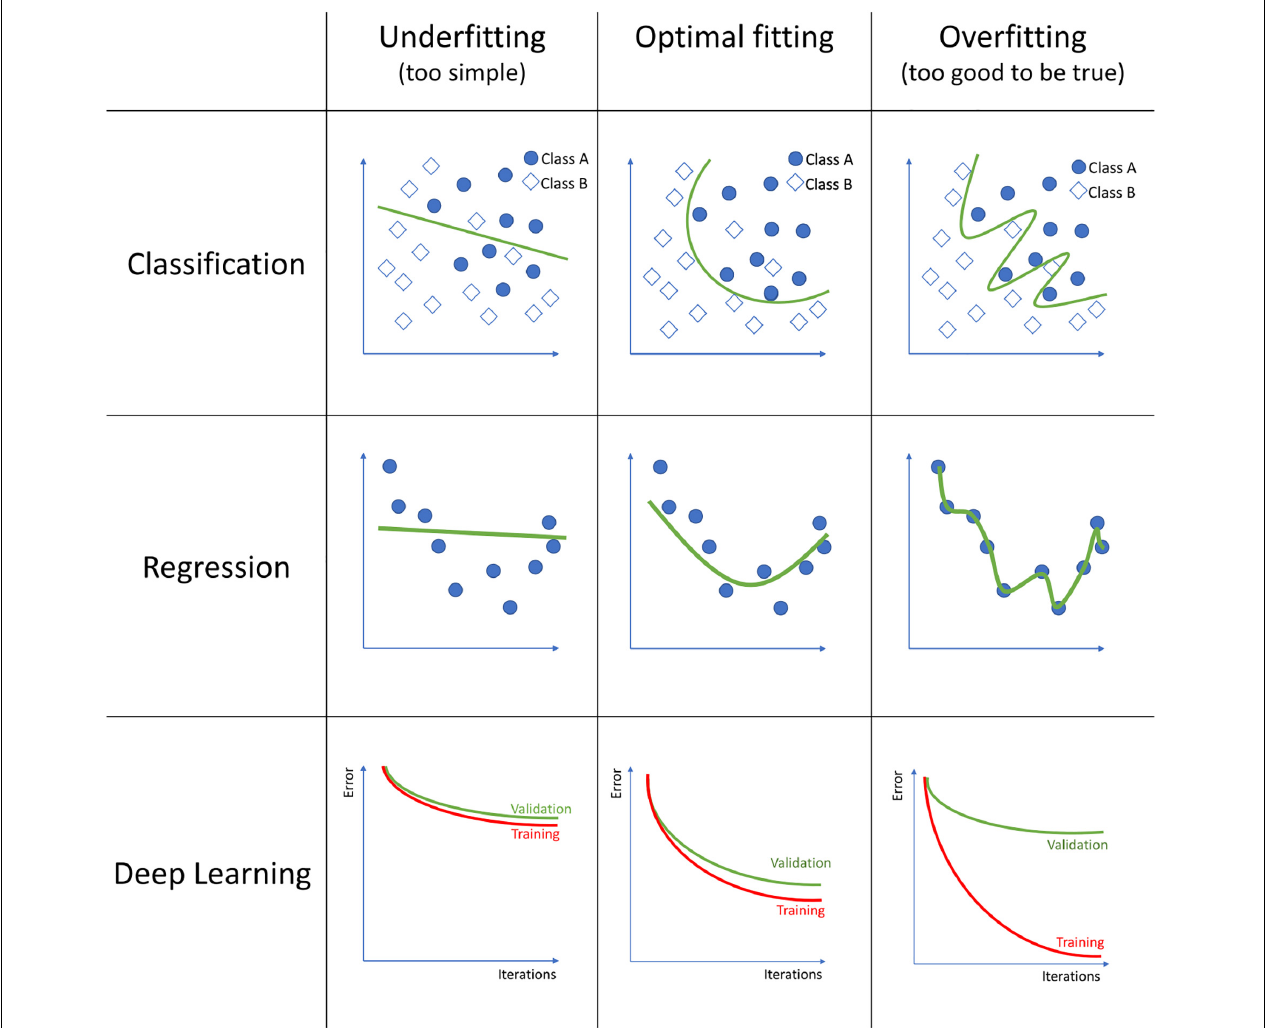
FIGURE 1 | Examples of model underfitting, model fitting good, and a model overfitting to the data on classification, regression, and deep learning models. In classification, squares and circles represent two different classes. In Deep Learning, the figures represent the training and validation error over each iteration during the model training